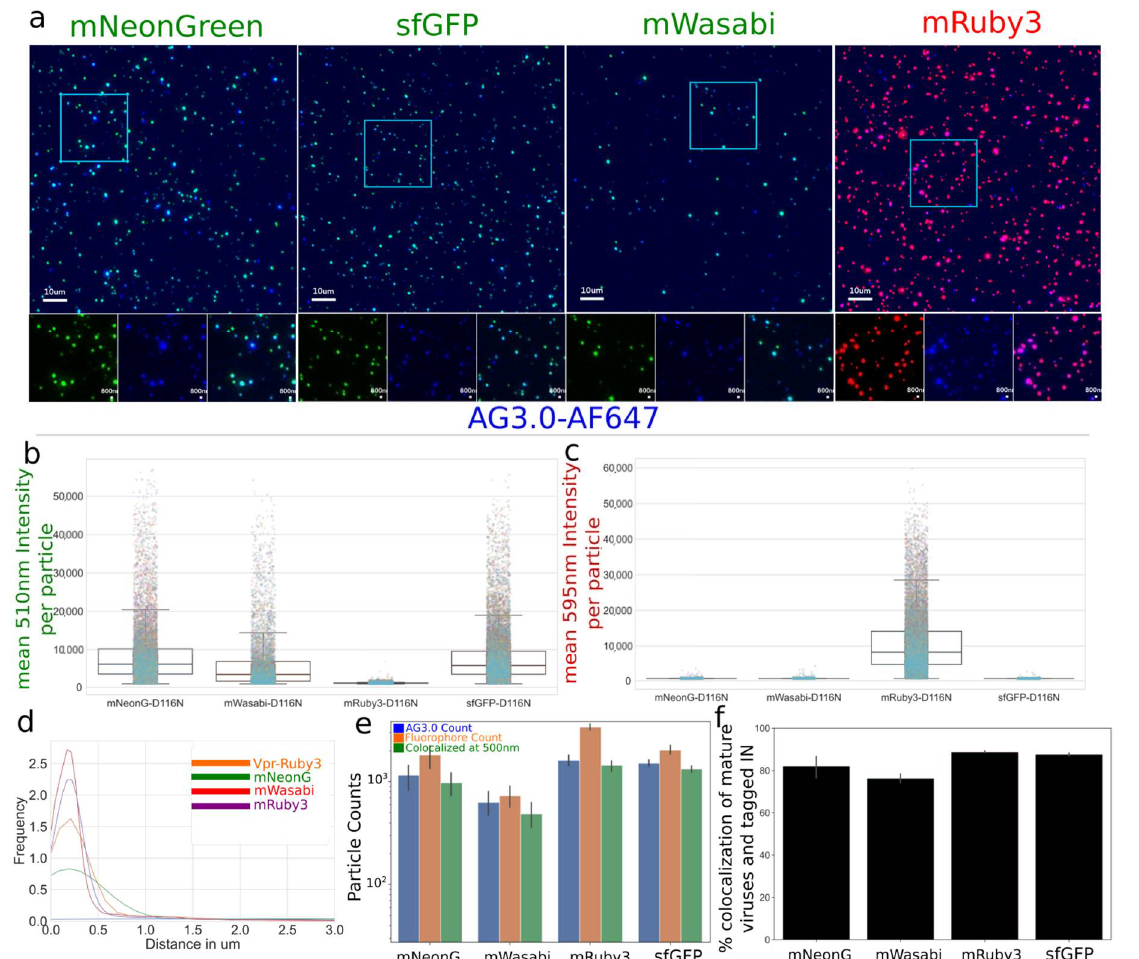
Figure 3. ( a – c ) Viruses spun on glass, fixed, and stained with AG3.0 antibody were produced with a non-fluorescent construct (pNL4-3-D116N-dEnv) that allows particle maturation by coding for HIV-1 Pol and high signal level in low excitation conditions. Green (mNeonGreen, sfGFP, or mWasabi), Red (mRuby3), Blue (mAB AG3.0 and anti-mouse-AF647) ( d – f ) As non-fluorescent particles are possible with trans complementation to pNL4-3 because the molecular clone does not code for any fluorescent protein, we quantified the frequency of labeled particles. We measured high levels of colocalization between mature particles, as identified by AG3.0 antibody, and the tagged IN, ranging from 75% to 90% colocalization. Colocalization was defined by centroids within 500nm of each other. Data represents one of the three repeated experiments with multiple technical repeats (>20) per experiment and thousands of viral particles analyzed (as shown in b